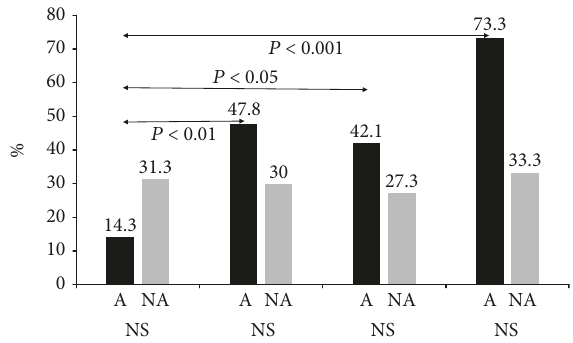
Figure 3: Positive allergic family history rates according to the age group. A, asthma group; NA, nonasthma group. Positive allergic family history rates were signi fi cantly higher in the older age groups than in the 0 – 1-year-old age group (NS, p < 0 01 ).